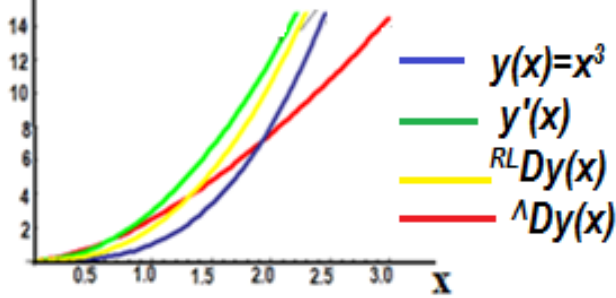
Figure 1. The various derivatives of the function y = x 3 . The blue curve indicates the function y = x 3 and the green one is the conventional derivative. Furthermore, the yellow one is the well-known Riemann–Liouville fractional derivative. However, the red one is the function of the Λ -fractional derivative transferred into the initial space. The action of the Λ -fractional derivative is more intense than the other